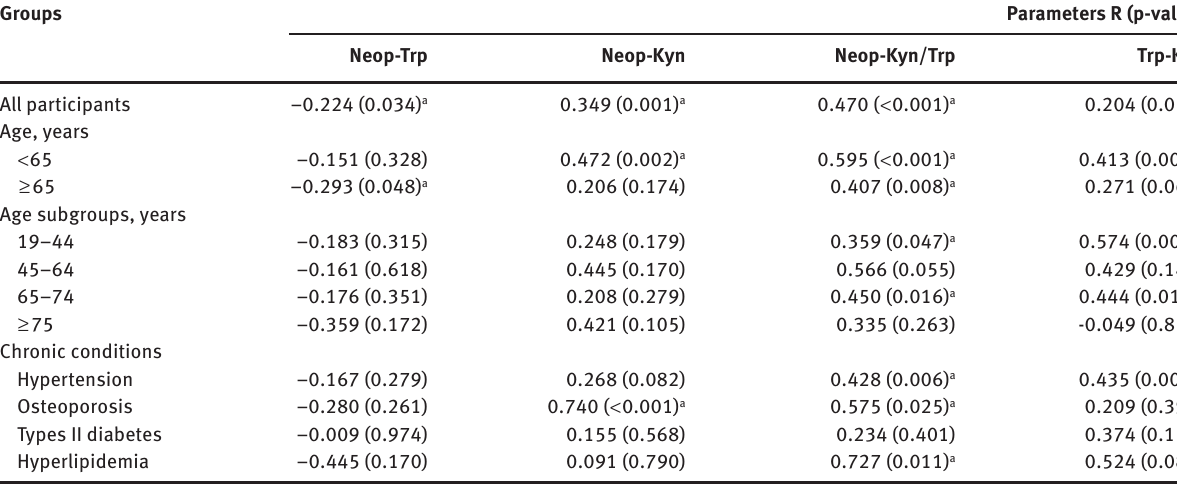
Table 3 Correlations between the measured parameters in groups. Groups